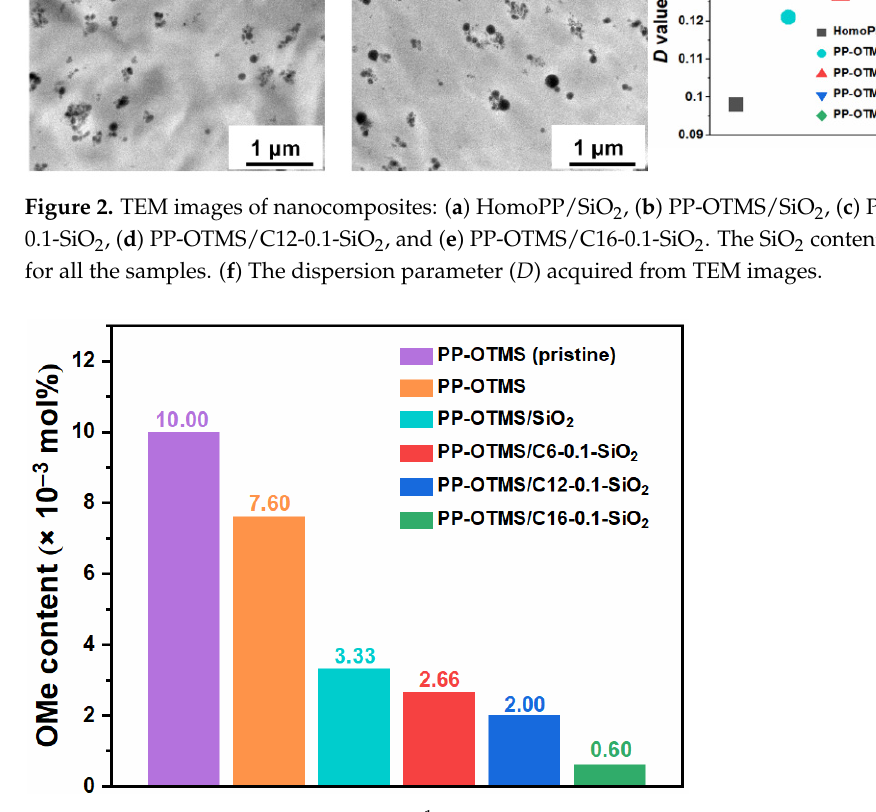
Figure 3. The OMe content analyzed by 1 H NMR before and after melt mixing.